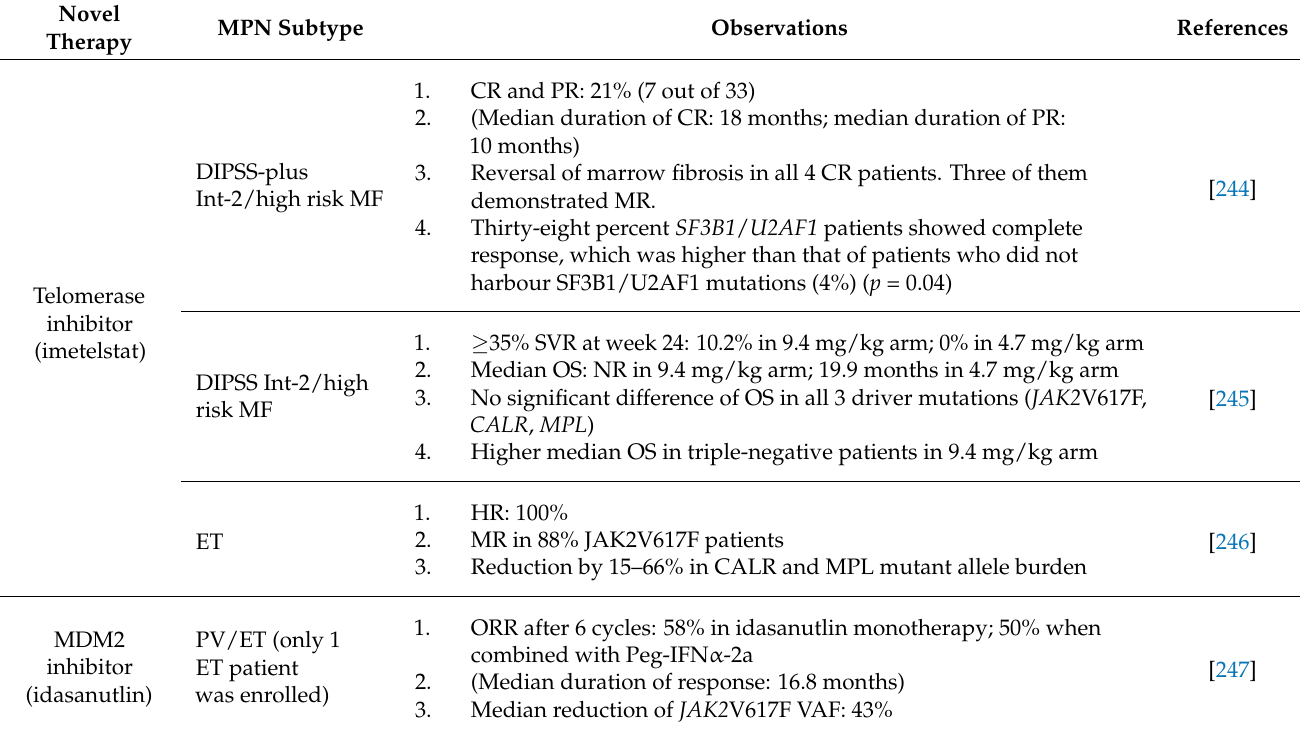
Table 3. Clinical trials of novel therapies as single agents for targeting Ph-negative MPNs. Novel MPN Subtype Therapy